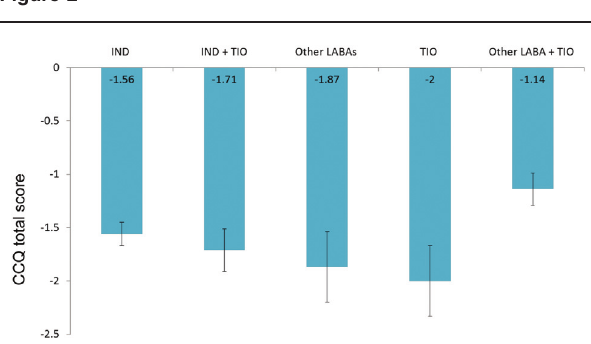
Changes from baseline in CCQ overall score in per-protocol set (last observation carried forward). Data are mean±SE; all P < 0.0001 for change in CCQ overall score from baseline to the end of the study. CCQ, Clinical COPD Questionnaire; LABA, long-acting β 2 -agonist; TIO, tiotropium; IND, indacaterol.